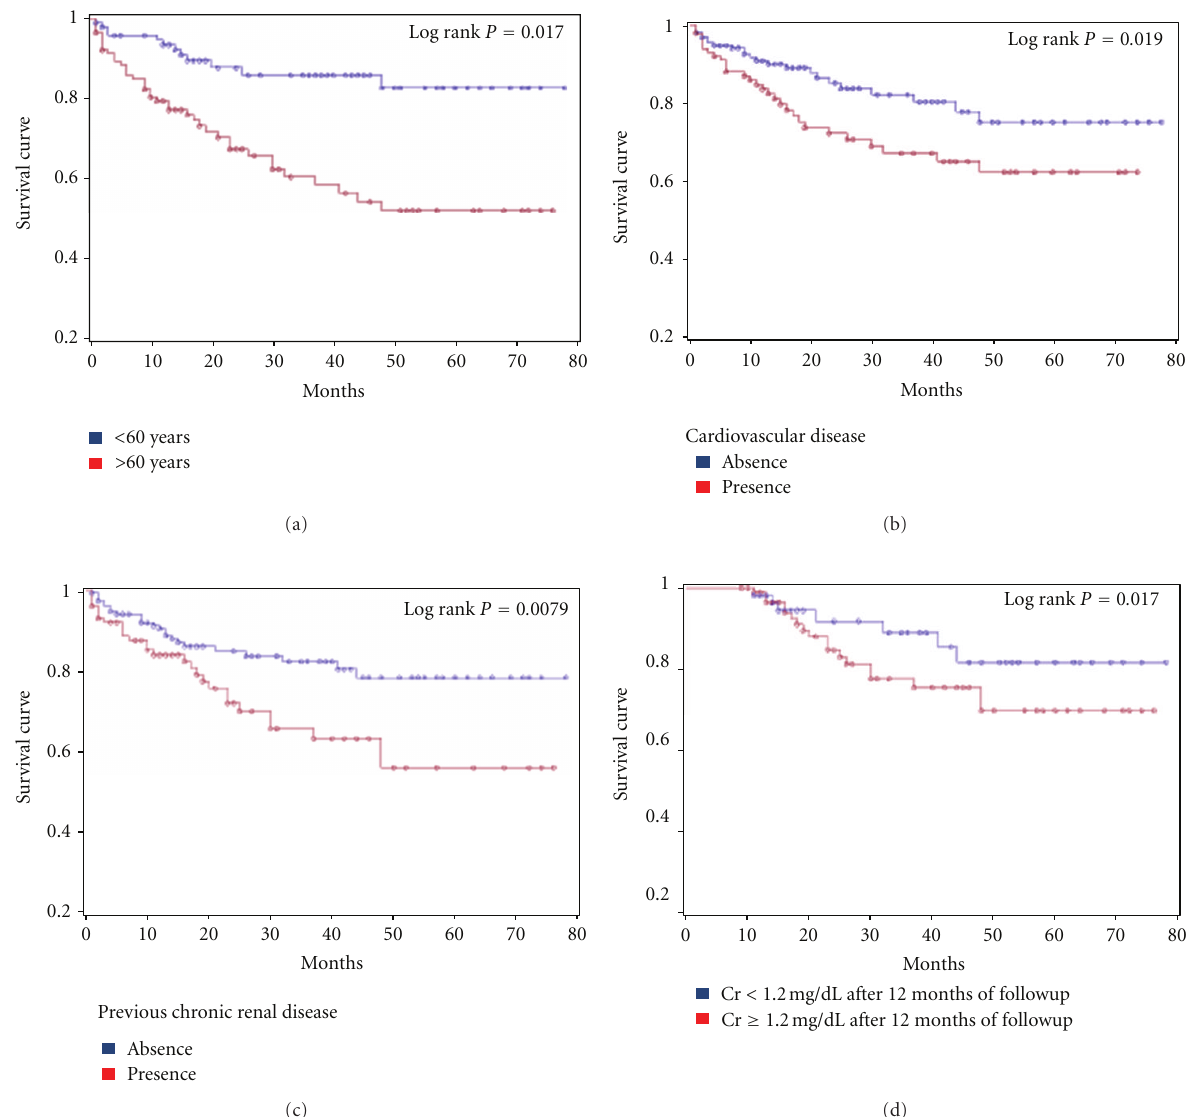
Figure 2: Kaplan-Meier survival curves according to (a) age; (b) the presence or absence of cardio-vascular disease; (c) the presence or absence of previous chronic renal disease; (d) serum creatinine after 12 months ≥ or < 1.2msg/dL.